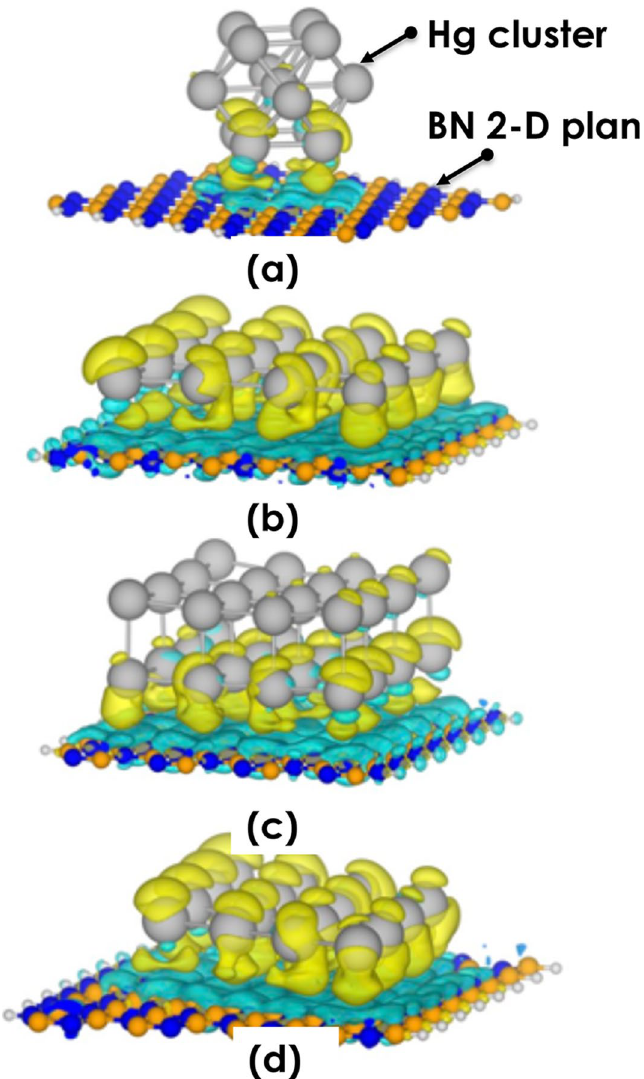
Figure 5. The charge density difference between Mercury and the hBN surface of configuration ( a ) the fcc cluster of Mercury on hBN, ( b ) the Hg (101) surface on hBN surface, ( c ) 2 layers of Hg (101) surface on hBN surface, and ( d ) the Hg (003) surface on hBN surface. The structures are optimized using the plane-wave basis sets at the PBE/D3 level of theory, including the scalar relativistic effect in the pseudopotentials. The iso-value of the charge difference is fixed to 0.0001 e/a.u. 3 . Yellow and blue colors indicate positive and negative levels that correspond to the gain and loss of